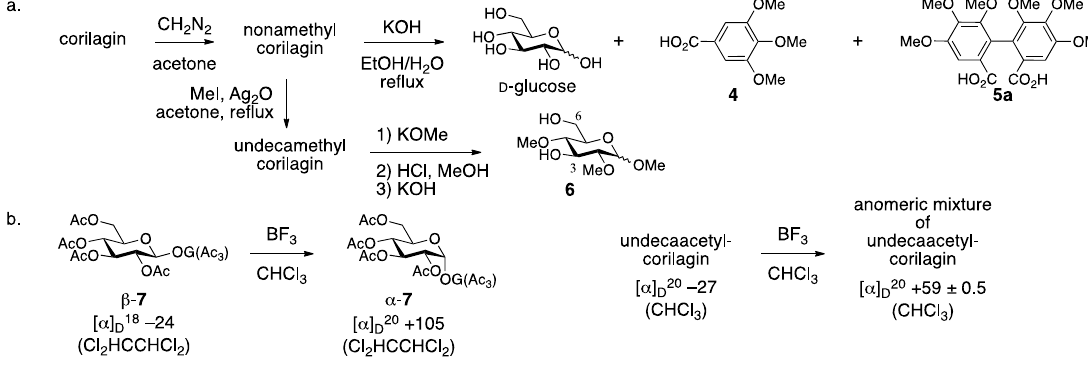
Figure 3. ( a ) The successive methylation and degradation of corilagin and ( b ) the basis for β -stereochemistry at the anomeric position.